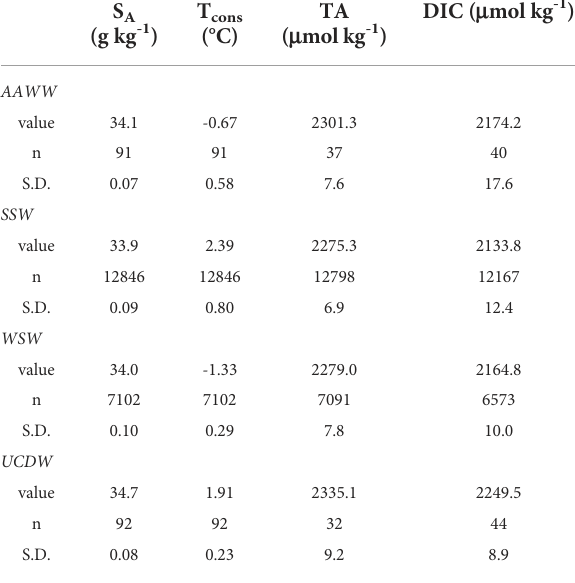
TABLE 1 Values of absolute salinity (S A ), conservative temperature (T cons ), TA, and DIC in each endmember water